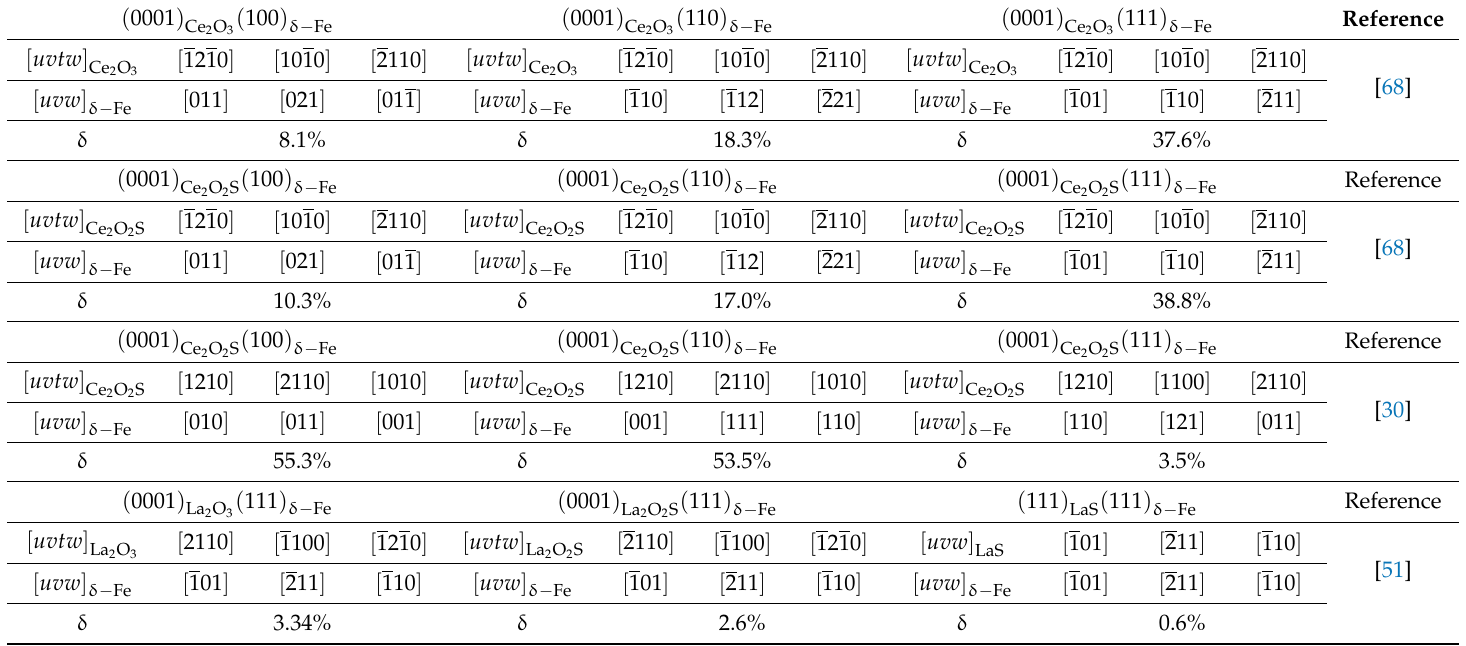
Table 2. Planar misfits between Ce 2 O 3 , Ce 2 O 2 S, La 2 O 3 , La 2 O 2 S, LaS, and δ -Fe.